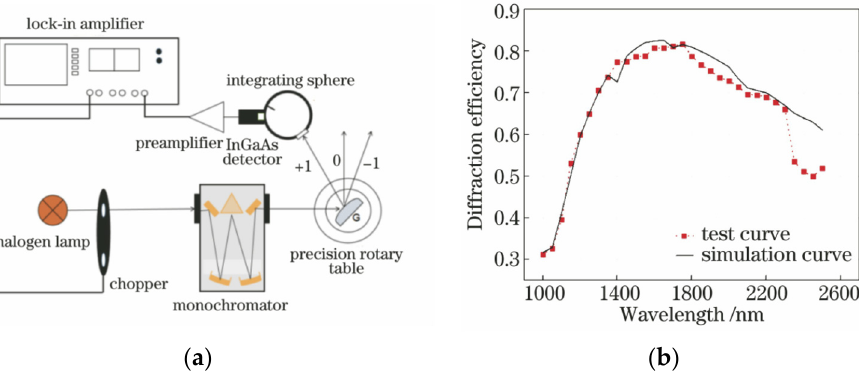
Figure 14. Test setup and curve for diffraction efficiency of convex grating. ( a ) Schematic diagram of the grating diffraction efficiency test setup [65]. ( b ) Convex blazed grating diffraction efficiency curve [65].